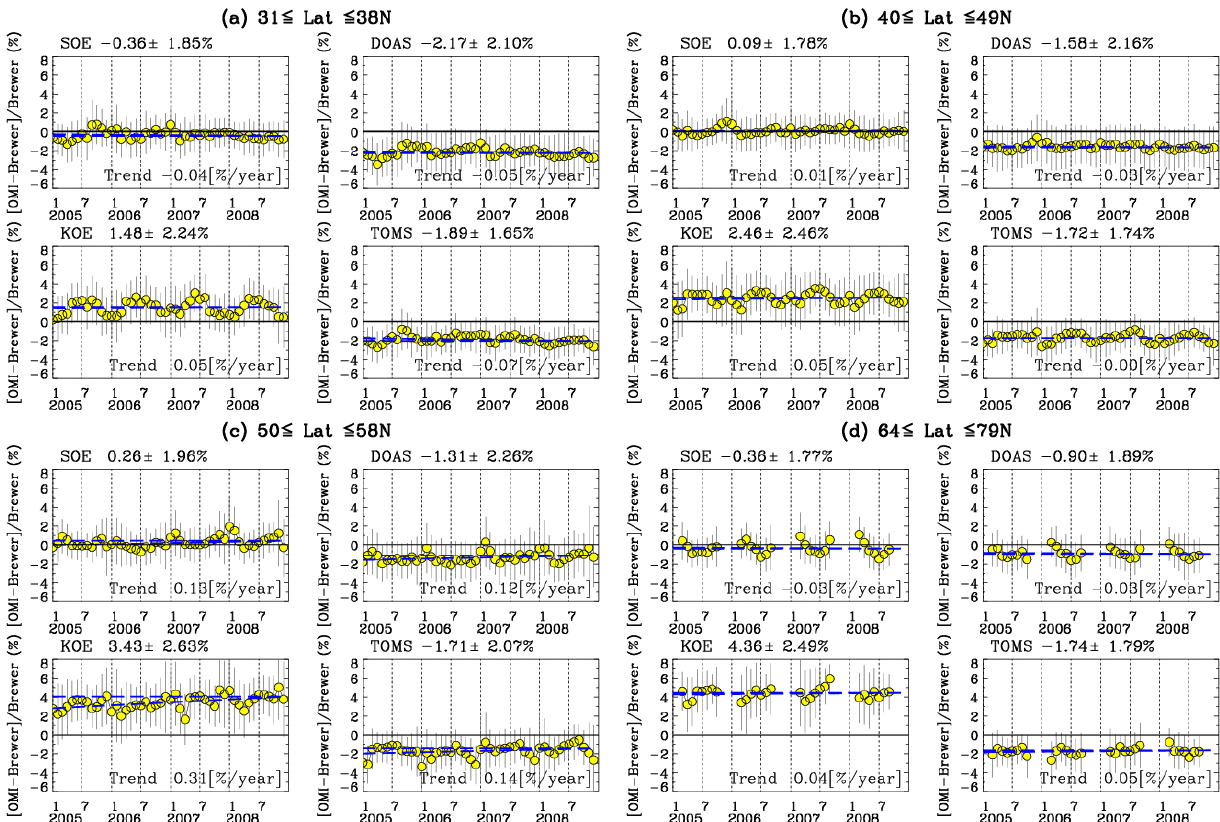
Figure 7. Time series (monthly) of relative differences (yellow circles) between OMI and Brewer total ozone columns over four selected latitude bands and the 1 σ standard deviations (vertical bars). The blue dashed line indicates the linear regression with the linear trend shown at the bottom of each panel. The title of each panel indicates the overall mean bias and standard deviation.